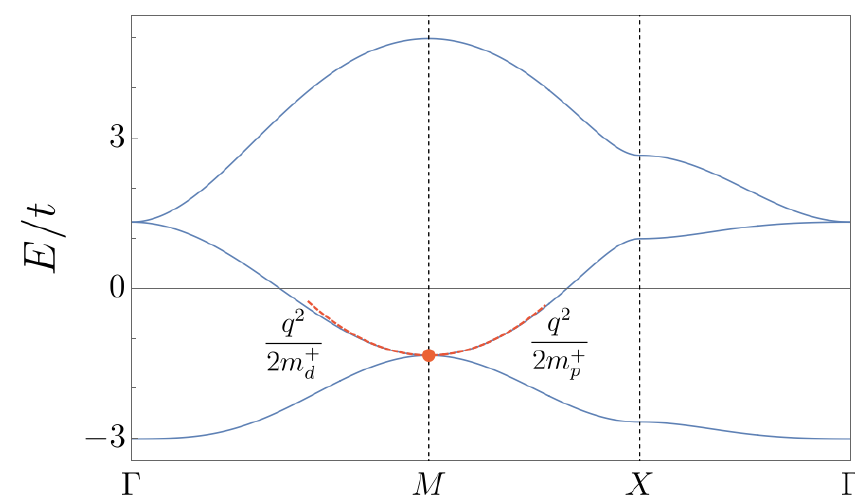
Figure 2: Quadratic band touching : The band structure of the three band model Eq. (3) in the strong hybridization limit. Two QBT points are present in the Γ and M points. We concentrate on the lower energy QBT at the M point, indicated with a red dot, as there are no other bands at this energy (i.e. it is an isolated quadratic band touching). We define the curvature of the quadratic bands with the effective masses m ± , where the effective dispersion near QBT for the upper band is shown p / d as dashed